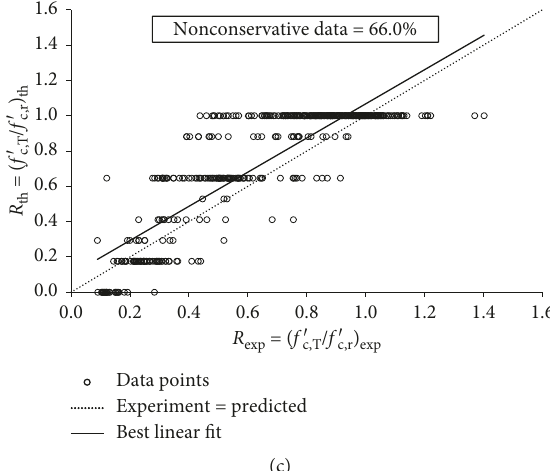
Figure 10: Comparison of normalized strength of HSC predicted by the models of different codes with experiment: (a) Eurocode 2: EN 1992-1-2 [4], (b) ACI 216.1-07 [5], and (c) ASCE Manual [6].